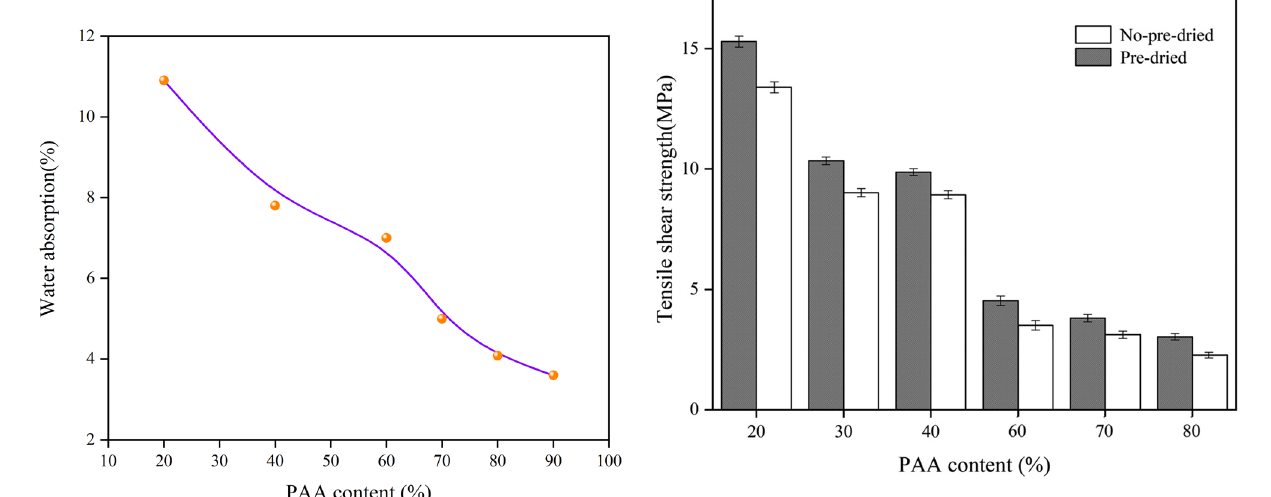
Figure 7: E ff ects of PAA content and curing treatment on tensile shear